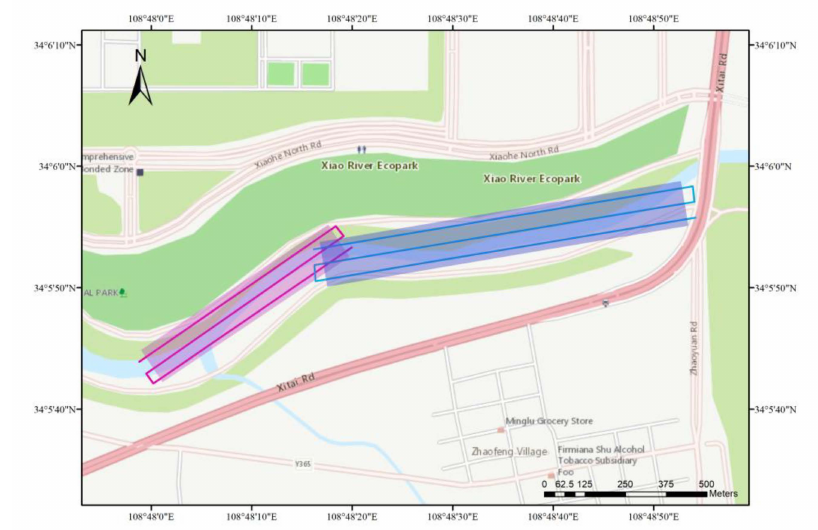
Figure 3. The detailed route planning and the flight area of UAV in the